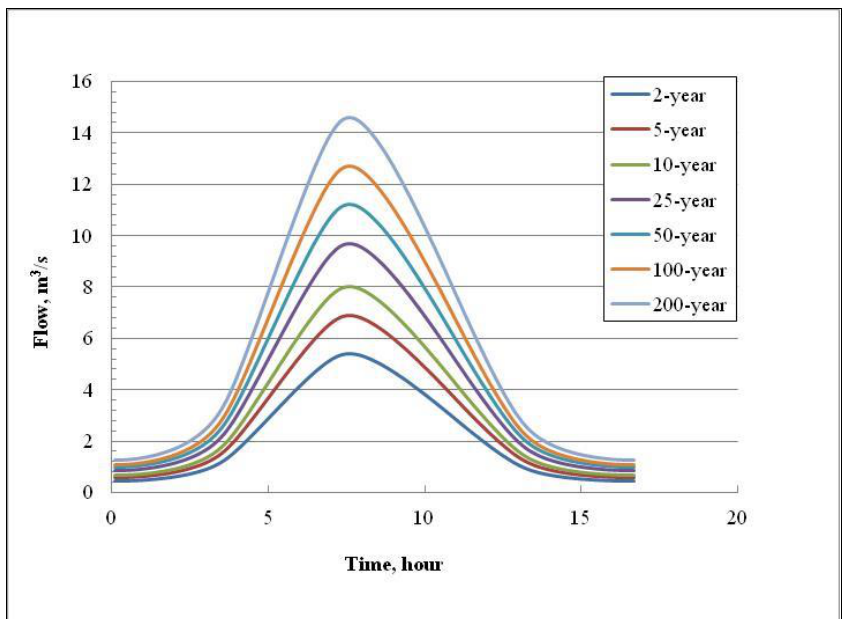
Figure 4. Design flow